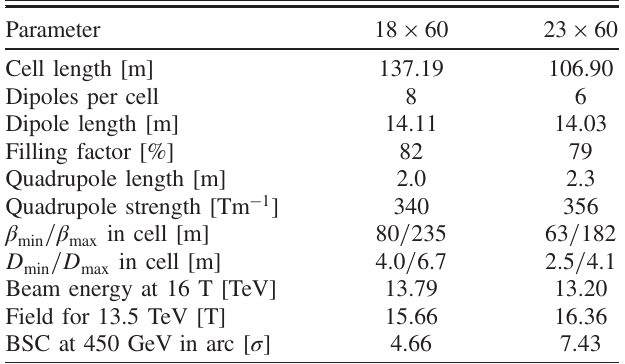
TABLE V. Parameters of the HE-LHC design options with 60° phase